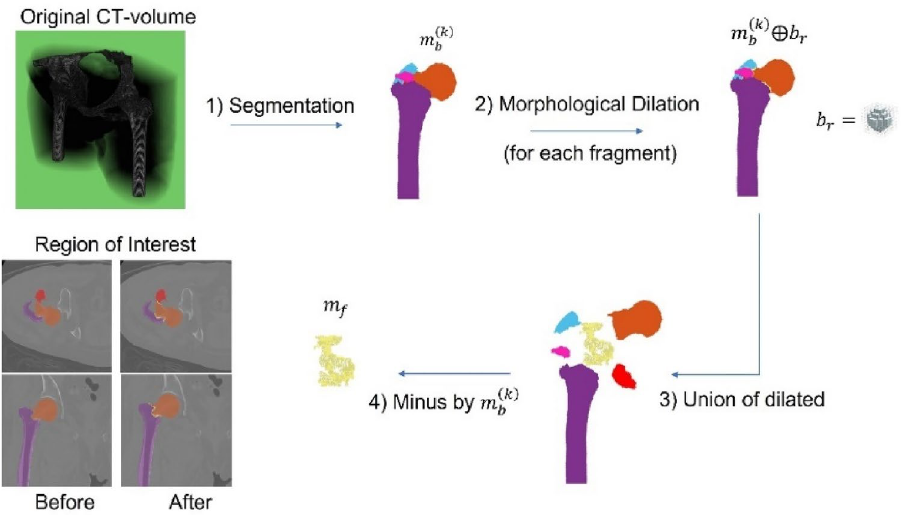
Figure 3. Workflow for synthesis of the Auxiliary class. The workflow includes (1) segmentation of each fragment femur as volume of interest; (2) morphological dilation of each fragment; (3) synthesis auxiliary volume; and (4) define it as the third class of